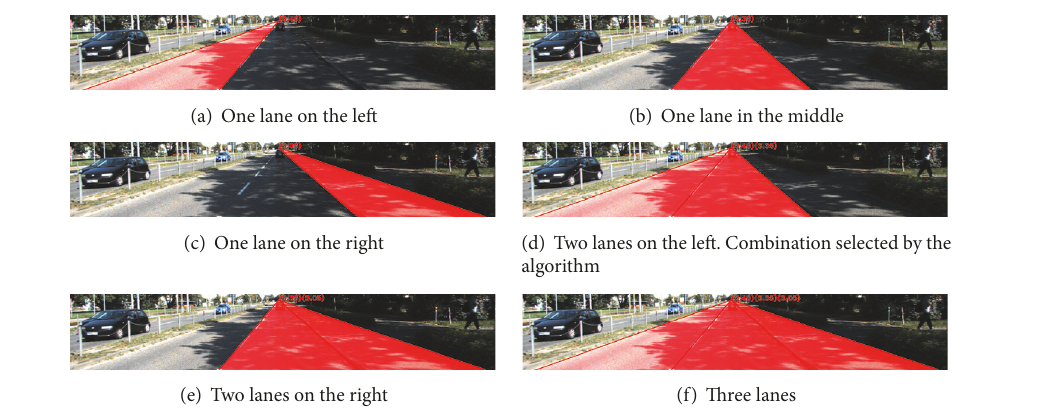
Figure 11: All possible lane combinations without high level